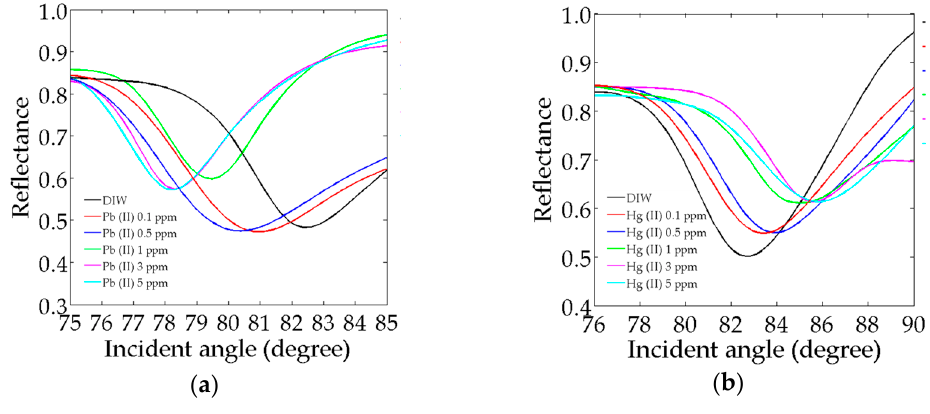
Figure 5. SPR reflectivity of the Au/Ag/Au/CS–GO SPR sensor in ( a ) Pb 2+ and ( b ) Hg 2+ ion.